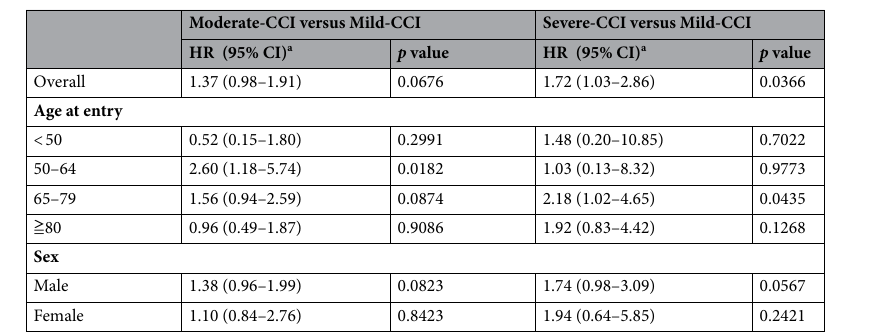
Table 5. The mortality risk among patients with traumatic brain injury and tuberculosis. CCI Charlson’s comorbidity index, HR hazard ratio, CI confidence interval, NHIRD National Health Insurance Research Database, TBI traumatic brain injury, ICU intensive care unit, TB tuberculosis, DM diabetes mellitus, ESRD end-stage renal disease, COPD chronic obstructive pulmonary disease. a Adjusted by the variables of age, gender, the length of stay, and the length of ICU stays, but excluding the stratified variable in the